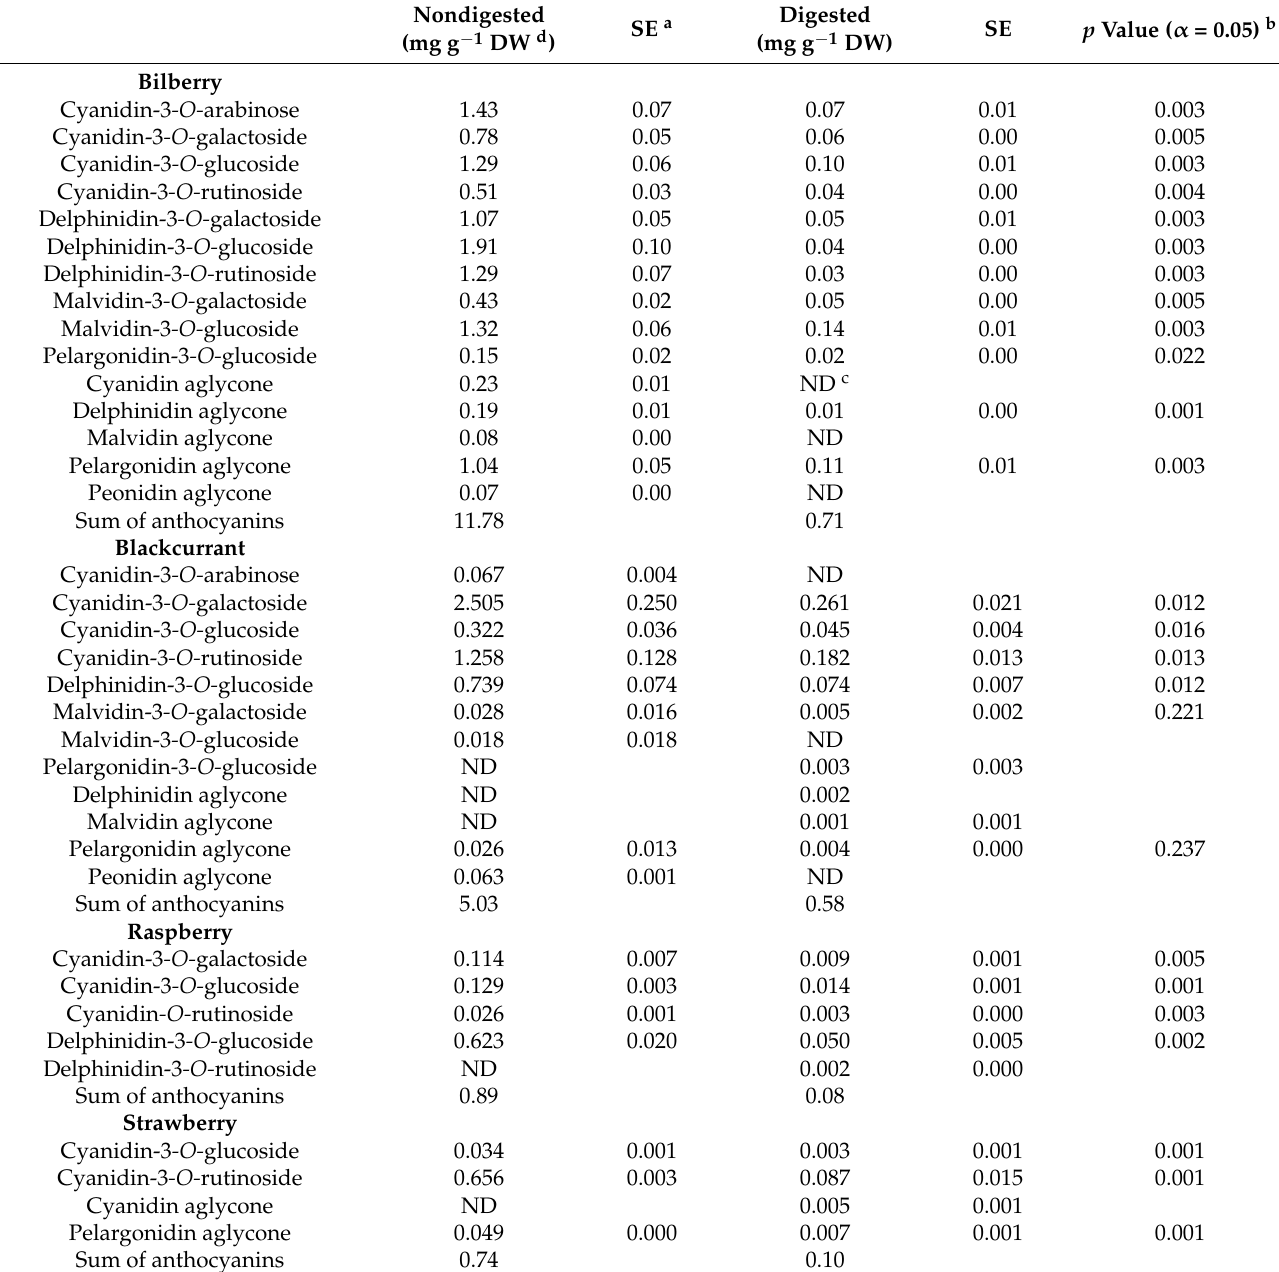
Table 1. Anthocyanin profiles of digested and nondigested bilberry, blackcurrant, raspberry and strawberry.